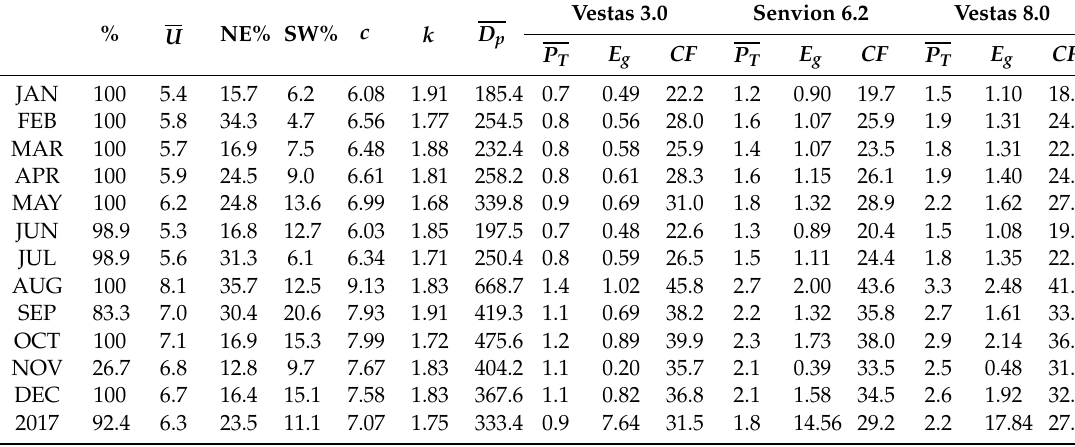
Table 3. Wind resource, Weibull distribution parameters, and production of the three turbines in monthly and annual averages for the year 2017 from 10 min LIDAR data at 110 m high. Percentage % refers to LIDAR data coverage for the period. U is the mean wind speed (m s − 1 ). NE% and SW% are the percentages of northeasterly (45 ◦ ± 15 ◦ ) and southwesterly ( − 135 ◦ ± 15 ◦ ) winds, respectively. The Weibull scale parameter c (m s − 1 ) and Weibull shape parameter k are indicated. D p is the mean power density (W m − 2 ), P T is the mean output per turbine (MW), E g is the generated energy (GWh), and CF is the capacity factor